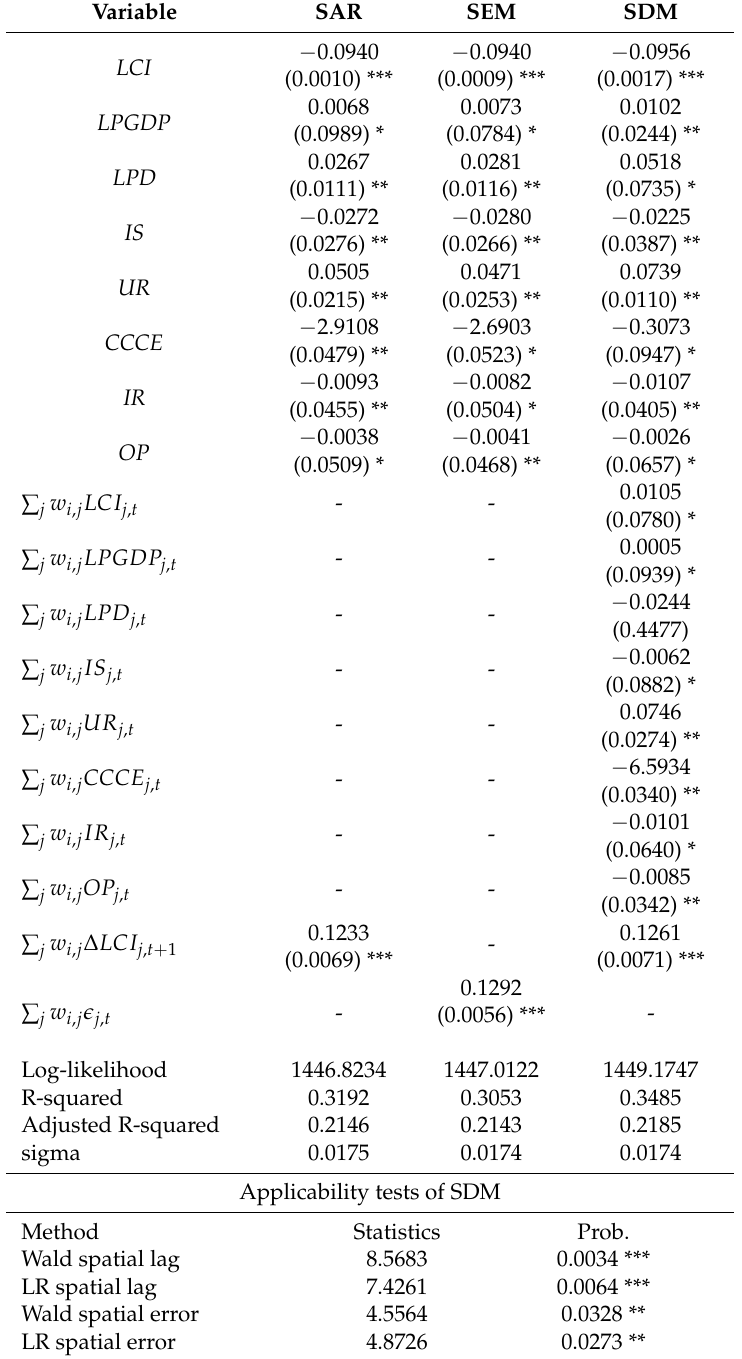
Table 11. Estimation results of conditional convergence of carbon intensity ( p -values in